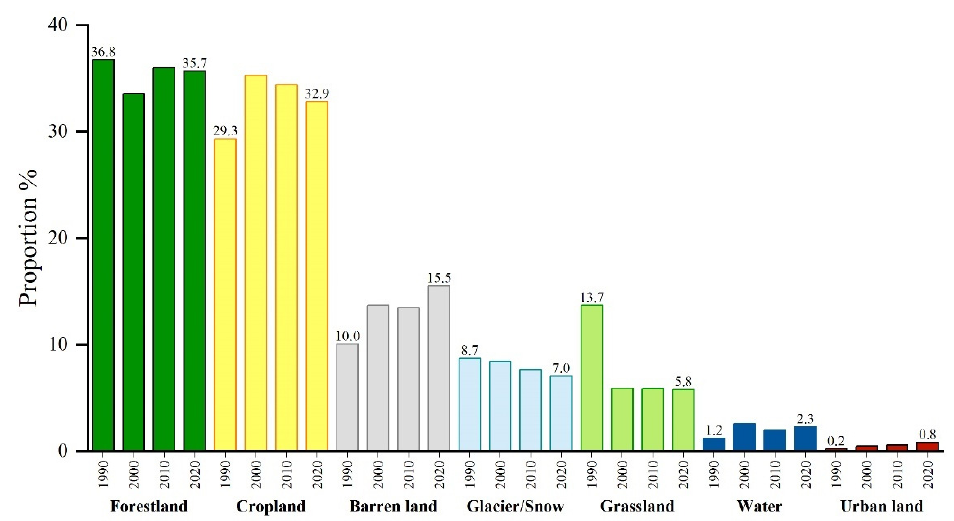
Figure 2. Percentage change in the area of land cover type in GRB from 1990 to 2020. The land cover transfer matrix for the period 1990 to 2020 is shown in Table 2. As